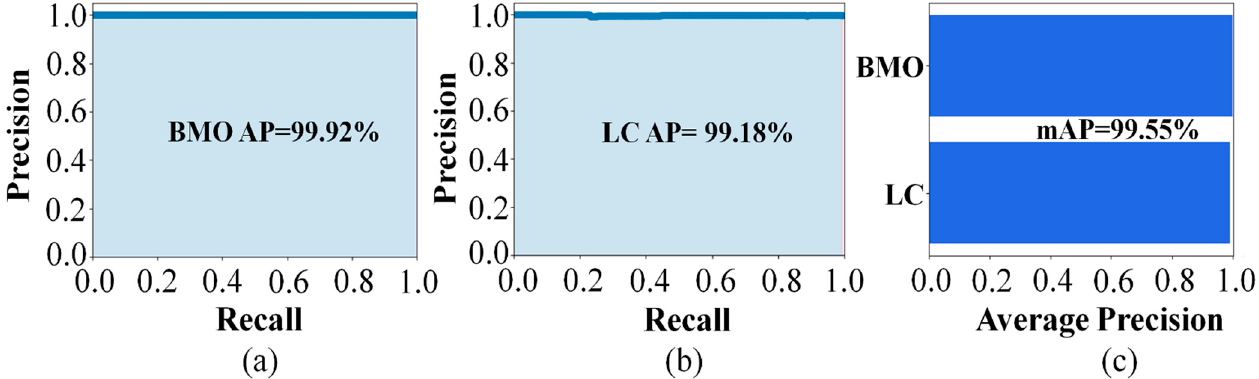
Figure 9. Learning results for the performance of the object detection model: Recall vs. Precision resulting in ( a ) 99.92% average precision (AP) for the BMO; ( b ) 99.18% (AP) for the LC; ( c ) the mean AP (mAP) for BMO and LC was 99.55%.